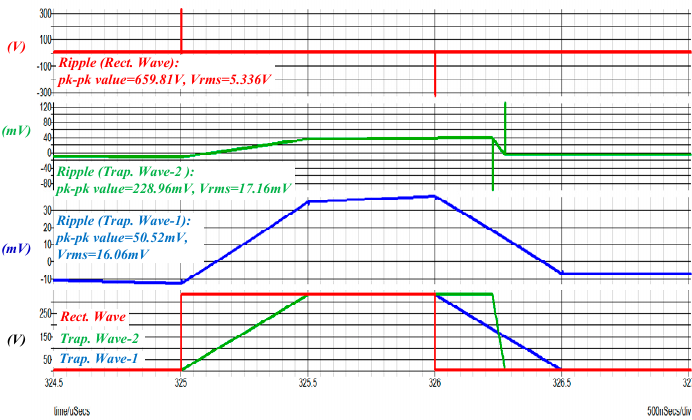
Figure 6. Simulation result of switching noise under different input voltage waveforms. pk-pk = peak–peak; V rms = rms value of voltage ripple.